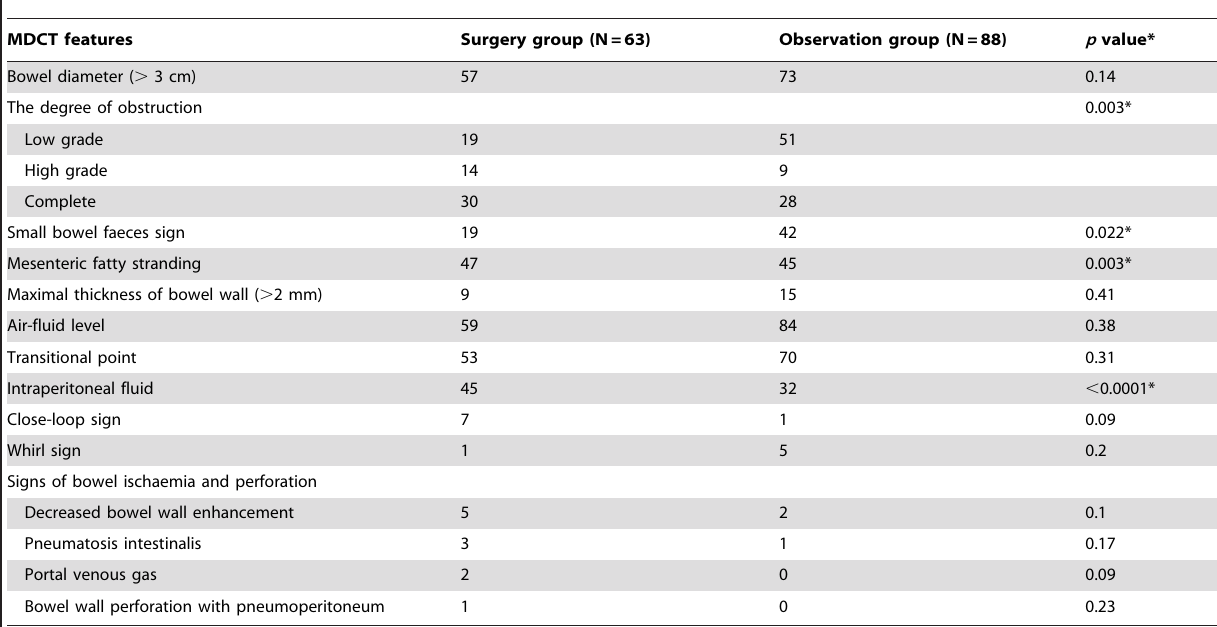
Table 2. Comparison of MDCT features in the surgery and observation